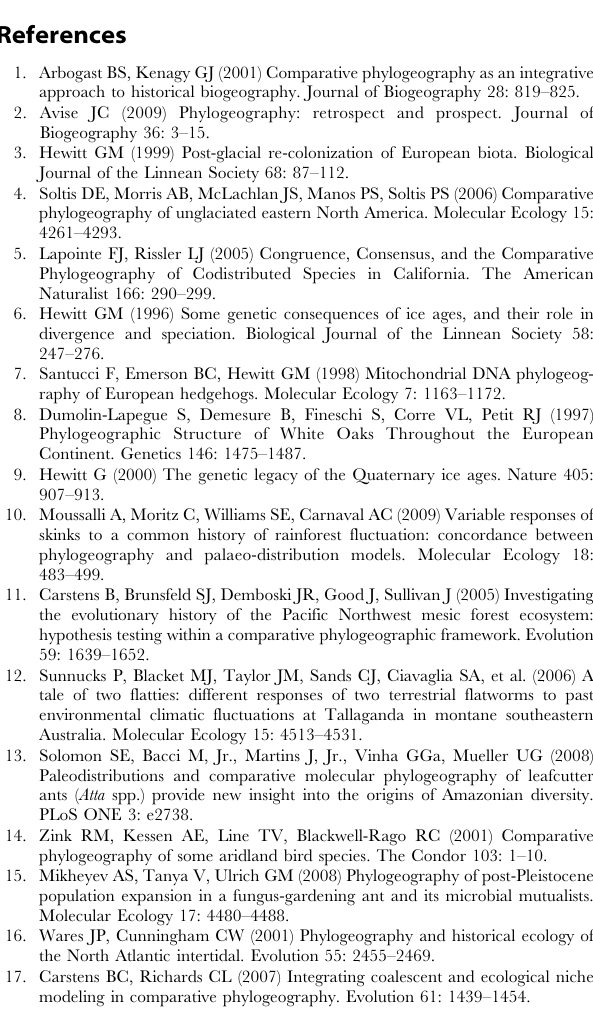
Figure S2 Extended Bayesian Skyline Plots inferred using BEAST v. 1.5.3 from sequence data simulated for each species under four alternative demographic sce- narios. The graphs depict mean values, averaged across one hundred (100) separate data sets. Note that the y-axes are not to scale. (TIF) Table S1 Collection localities for samples included in this study. (PDF) Table S2 Collection localities and GenBank accession numbers for insect samples. (PDF) Table S3 Collection localities and GenBank accession numbers for plant tissue. (PDF) Table S4 Worldclim variables included in estimation of paleodistributions. (PDF) Table S5 Location, carbon-14 ages, and calendar year ages estimated using CALIB 5.0.2 of fossil records for Y. brevifolia .. (PDF) Table S6 Summary of Lamarc simulations.